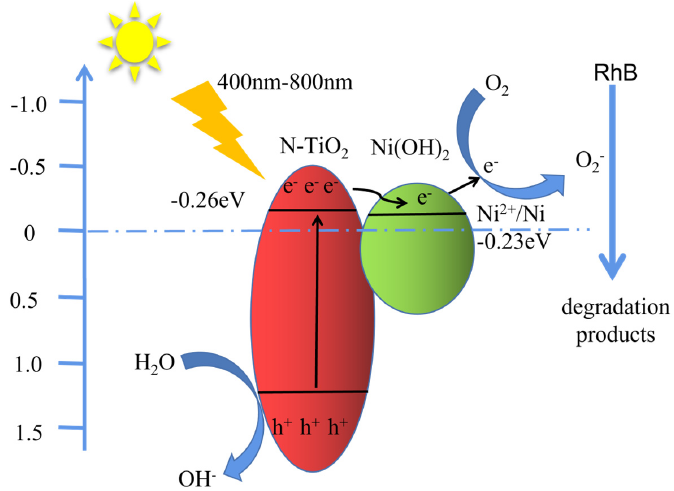
Figure 7. Schematic diagram of the mechanism of photocatalytic degradation of Rh B by Ni(OH) 2 /N- TiO 2 under visible light